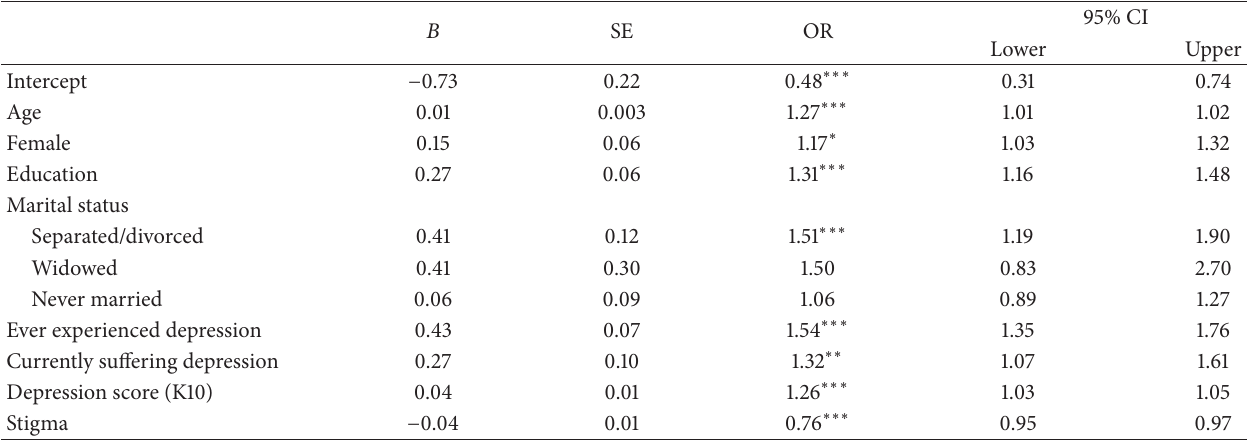
Table 2: Predictors of participation interest ( 𝑛 = 4758 ).